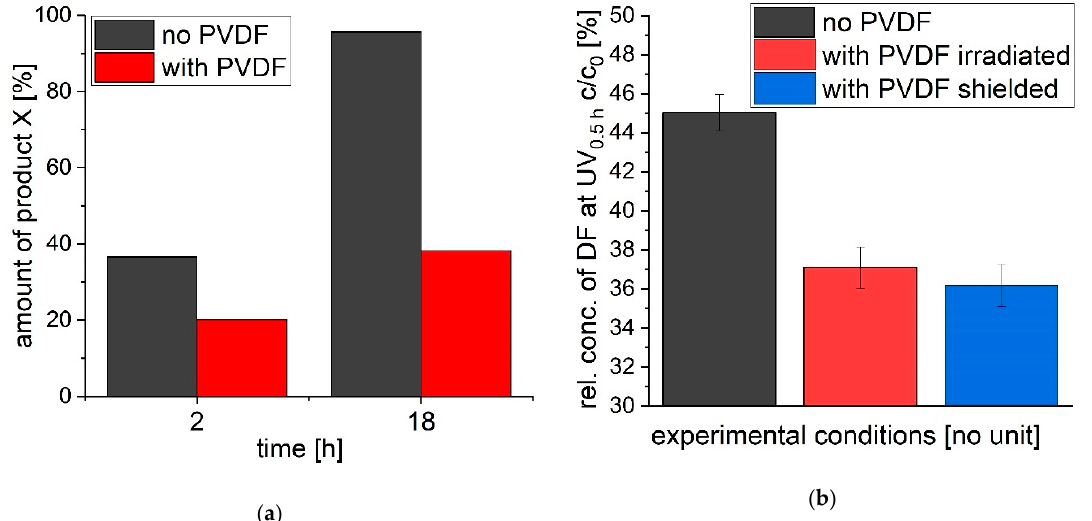
Figure 6. ( a ) Amount of product X in relation to other phototransformation products found via GC-MS after 2 h and 18 h of irradiation with and without PVDF. ( b ) The transformation of diclofenac with UVA for 0.5 h followed by analyzing the relative concentration of diclofenac via HPLC is shown. The irradiation was performed without PVDF, with PVDF irradiated during transformation and with PVDF shielded (not irradiated) during photoreaction. Polymers 2020 , 12 , x FOR PEER REVIEW